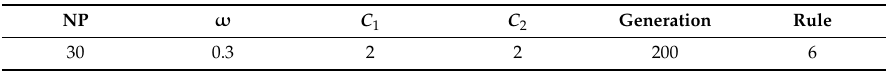
Table 1. DGCPSO parameters setting.